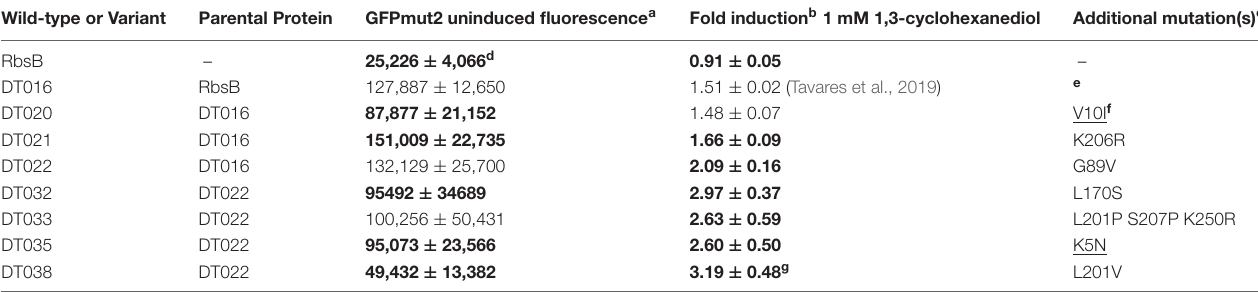
TABLE 1 | GPFmut2 fluorescence in Escherichia coli expressing wild-type- and mutant-RbsB proteins under uninduced and 13CHD-induced conditions. Wild-type or